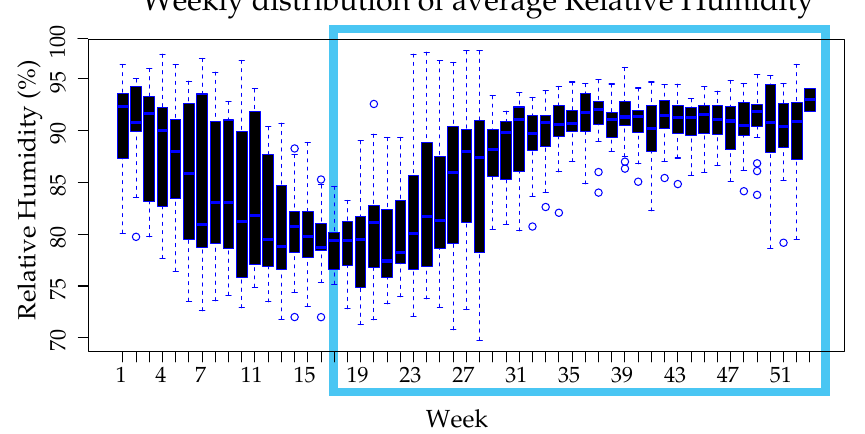
Figure 8. Weekly distribution of average Relative Humidity, grouped by week along the study